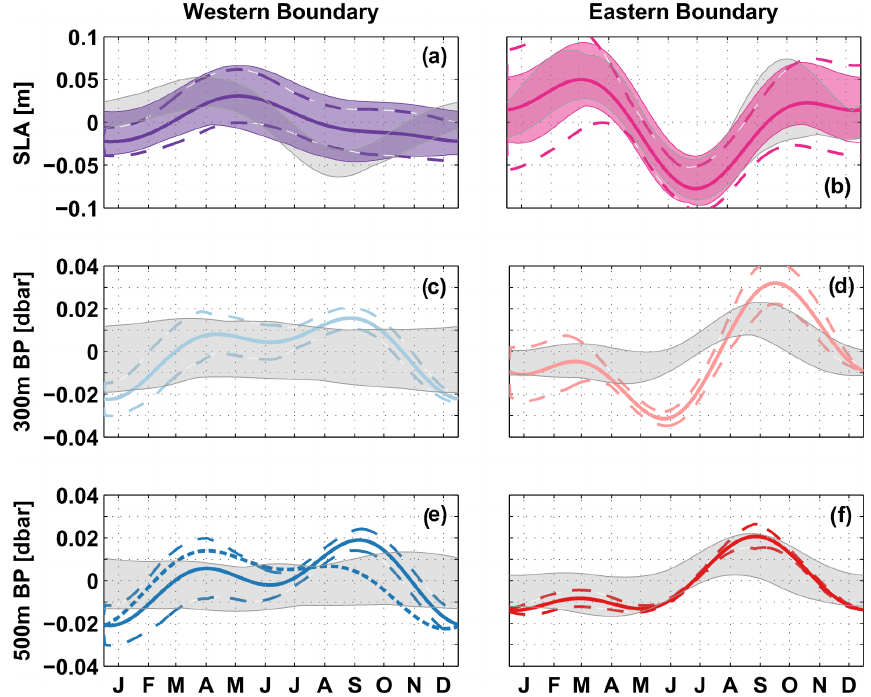
Figure 5. Combined annual and semi-annual harmonics calculated for (a, b) SLA, (c, d) BP at 300m and (e, f) BP at 500m depth. Line styles and colour coding are the same as in Fig. 4. Additionally, dashed envelopes around the solid curves give uncertainties for the amplitudes of the harmonics. These are calculated by 170d low-pass filtering the pressure time series and then subsequently the 95th percentile of the deviations from the derived annual and semi-annual harmonics for every day of the year.